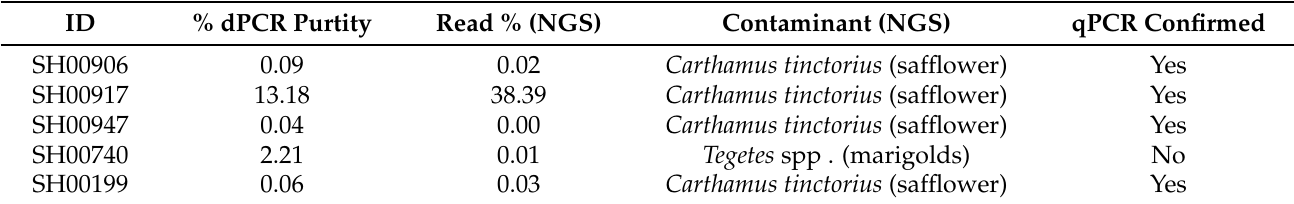
Table 3. Overview of the samples found suspicious by DNA analysis. For each sample the table shows its percentage digital PCR purity, the % of reads attributed to Crocus sativus in NGS metabarcoding, the contaminants as identified by NGS, and whether or not the contaminant presence has been confirmed by qPCR markers specific for that